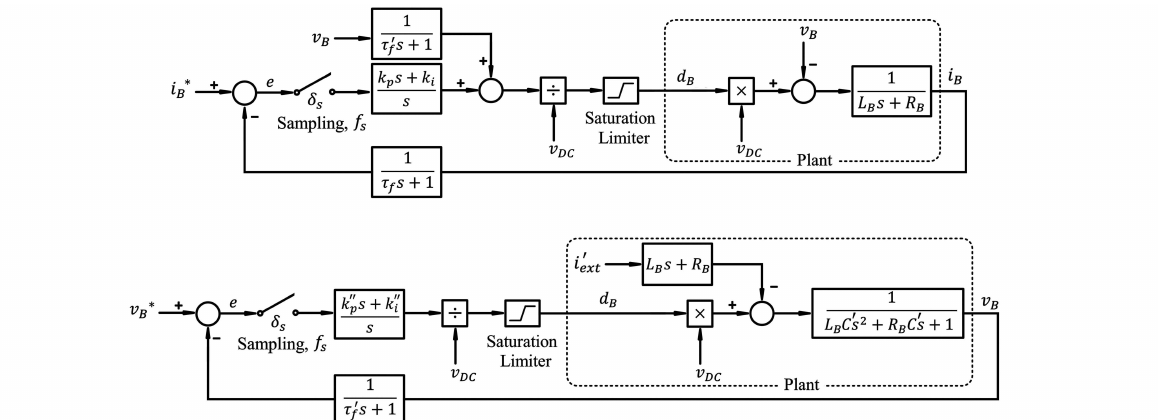
Figure 4. Detailed description of the control block diagrams of the DC-DC part depicted in Figures 1 and 2.